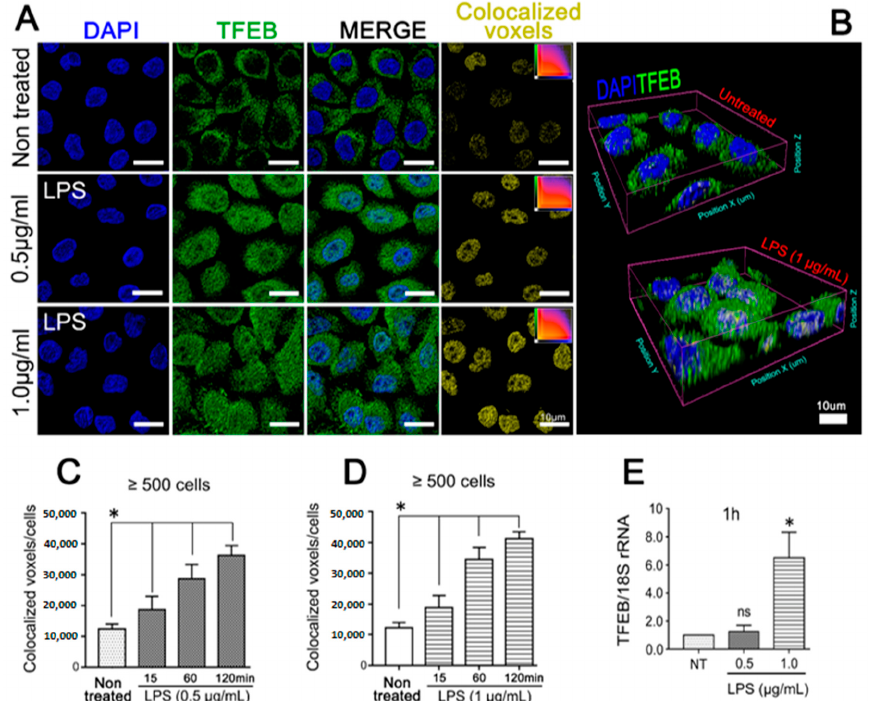
Figure 4. Purified LPS from A. actinomycetemcomitans induces TFEB activation. OKF6/TERT-2 cells were incubated with 0.5 or 1 µ g / mL of purified LPS from A.a (serotype b) and analyzed by ( A ) immunofluorescence visualized by confocal microscopy. Blue: DNA rich structures strained with DAPI; green: transcription factor EB labeled with anti-TFEB antibody; merge: digital overlap of blue and green channels; yellow: colocalized voxels from merged file. ( B ) 3-D reconstruction of confocal image data showing evident TFEB-labeling in LPS-stimulated JEK nuclei, scale bar 10 µm. Quantification of colocalized voxels of LPS-stimulated cells at different time points. ( C , D ) Quantification of colocalized voxels from DAPI and TFEB channels in LPS-stimulated cells at different time points. Cells were stimulated with 0.5 (C) or 1 µg/mL (D) of LPS for the indicated period of time. ( E ) Quantitative real-time PCR of TFEB transcripts abundance normalized to 18S rRNA levels after 1 h of LPS stimulation. * p < 0.05.